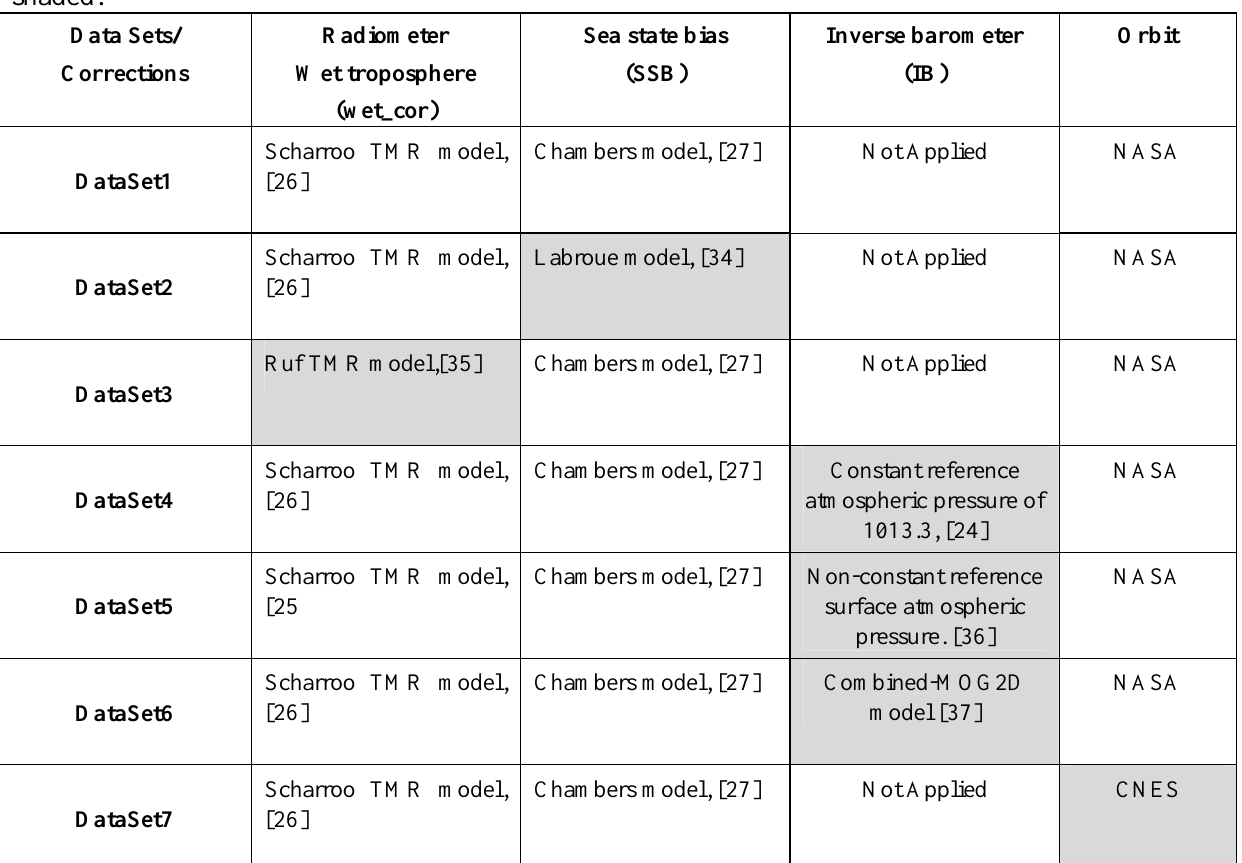
Table 2. Geophysical corrections and models used in the processing of the various TOPEX altimeter data sets. The box corresponding to the correction that has been changed with respect to DataSet1 is